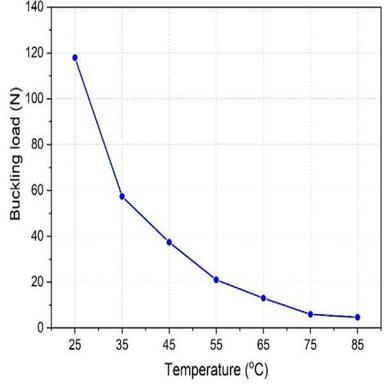
The change in buckling load with temperature for IM7/8552. (For interpretation of the references to colour in this figure legend, the reader is referred to the web version of this article.)